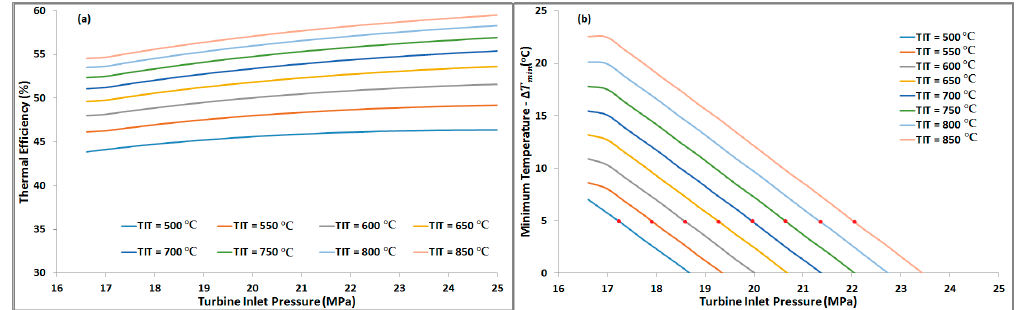
Figure 6. ( a ) Thermal efficiencies of the RBC-PC-IHR plotted versus turbine inlet pressure for TIT from 500 °C to 850 °C. ( b ) Minimum pinch temperature versus turbine inlet pressure; red dots represent the minimum pinch temperature of 5 °C. Table 2. Turbine inlet pressures at different turbine inlet temperatures for maximum thermal efficiency of the RBC-PC with improved heat regeneration (RBC-PC-IHR).